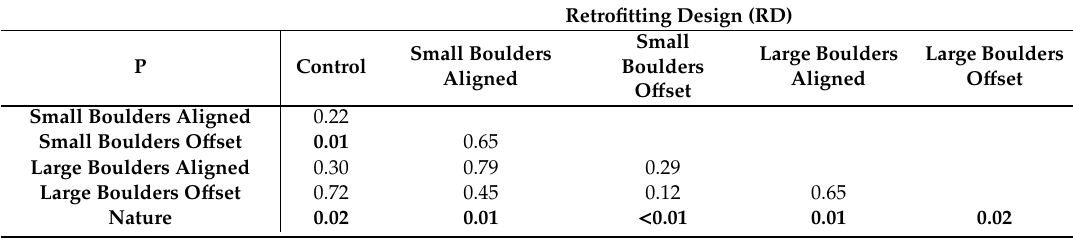
Table 2. Results of the pairwise comparisons, performed after the main test PERMANOVA, on the number of successful upstream passages (S) for the factor retrofitting design (RD). Bold values highlight significant di ff erences ( α =